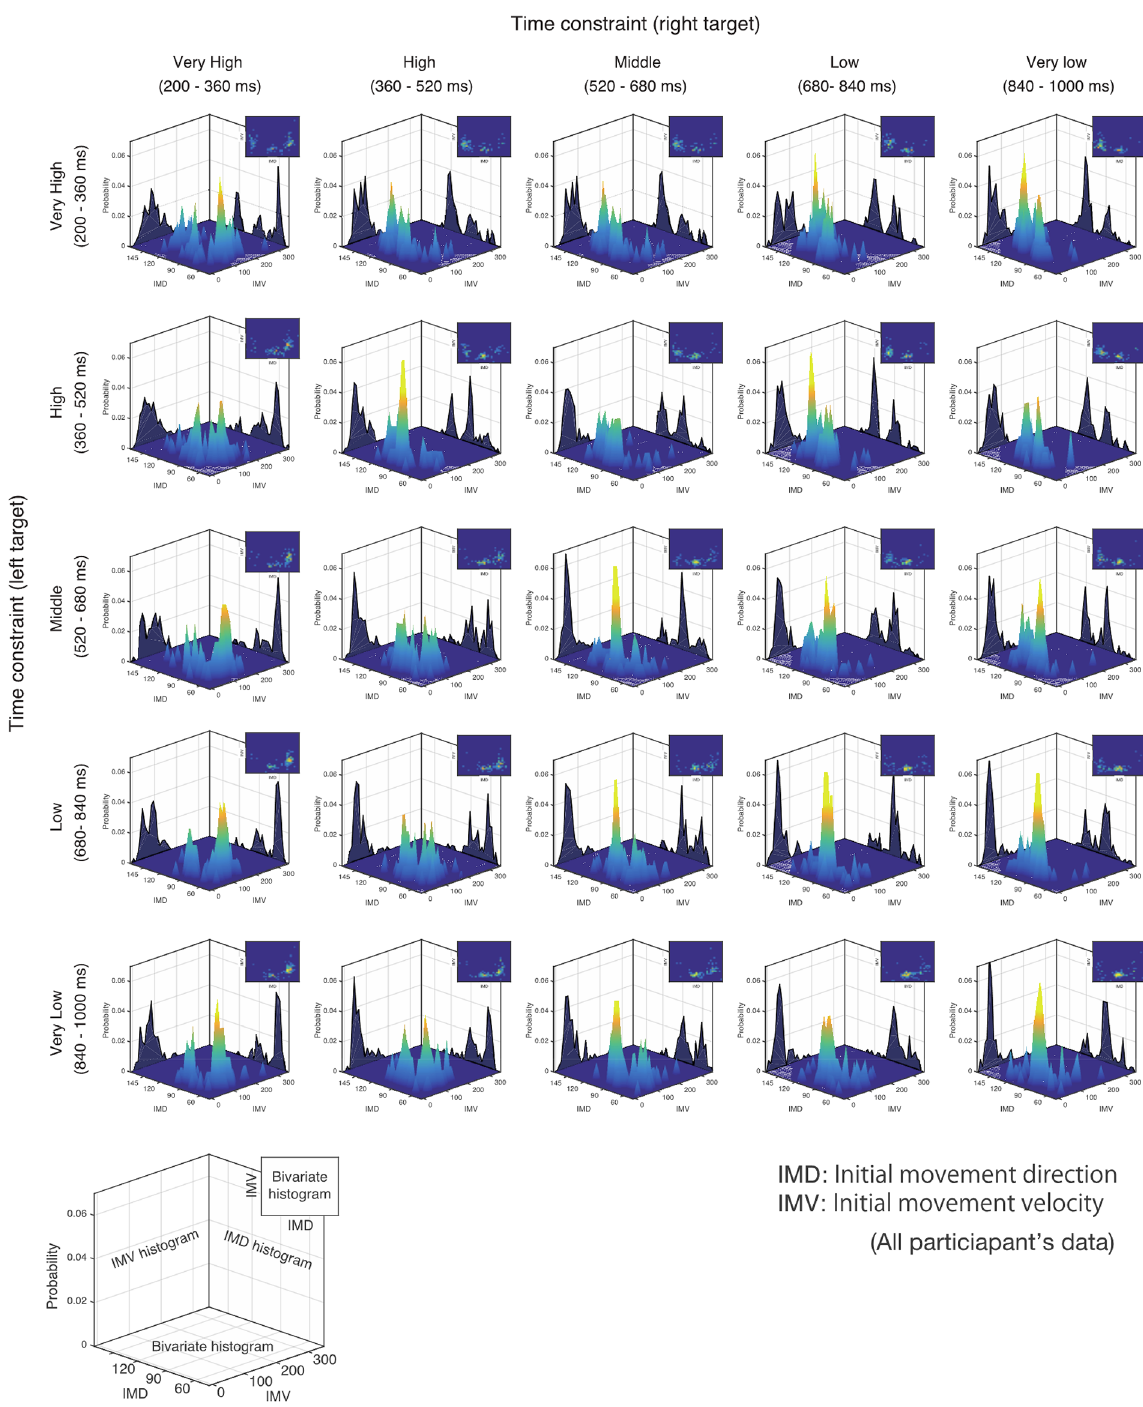
Figure 3. Bivariate histograms of the initial movement direction (IMD) and the initial movement velocity (IMV) according to the combinations of the time constraints. The bivariate histograms of the IMD and the IMV according to the time constraint in the double-target condition are shown. The center of each box shows the bivariate histogram, and the upper right corner shows the same histogram viewed from the vertical direction. As in Fig. 2, this Figure shows the change in the direction and velocity of the initial movement depending on the time constraint. In particular, the diagonal line from the upper left to the lower right shows a high frequency of initial movement in the center direction and a symmetrical distribution along 90° of the IMD. On the other hand, in the conditions where the difference in time constraints is large (lower left or upper right panel), the frequency of the initial movement in the target direction with tighter time constraints is high, although initial movement in the center direction also